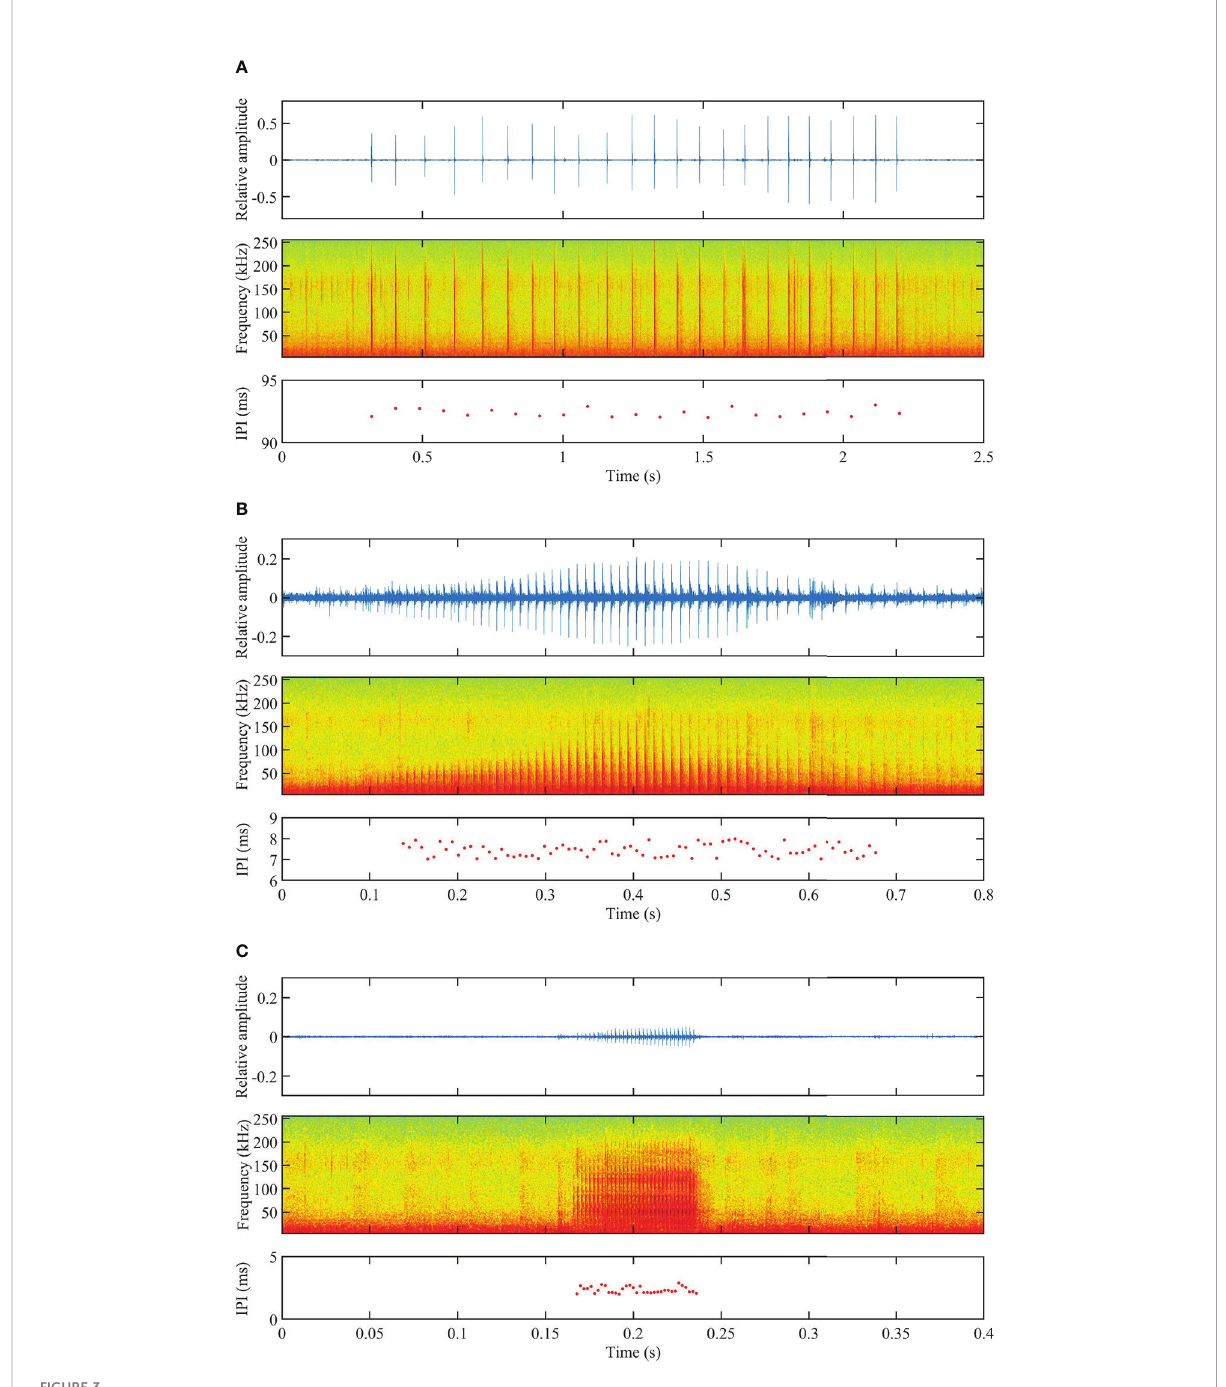
FIGURE 3 (Color online) Examples of waveforms (upper panels), spectrograms (middle panels), and IPIs throughout the pulsed signal train (bottom panels) showing a (A) click, (B) burst-pulse, and (C) buzz, representatively, produced by Indo-Paci fi c humpback dolphins. Spectrogram settings: high pass fi lter, fi lter-out noise under 4 kHz, Hamming window, FFT size = 512 points, frequency overlap = 50%. (Please note the difference in time scales (x-axis) on the three